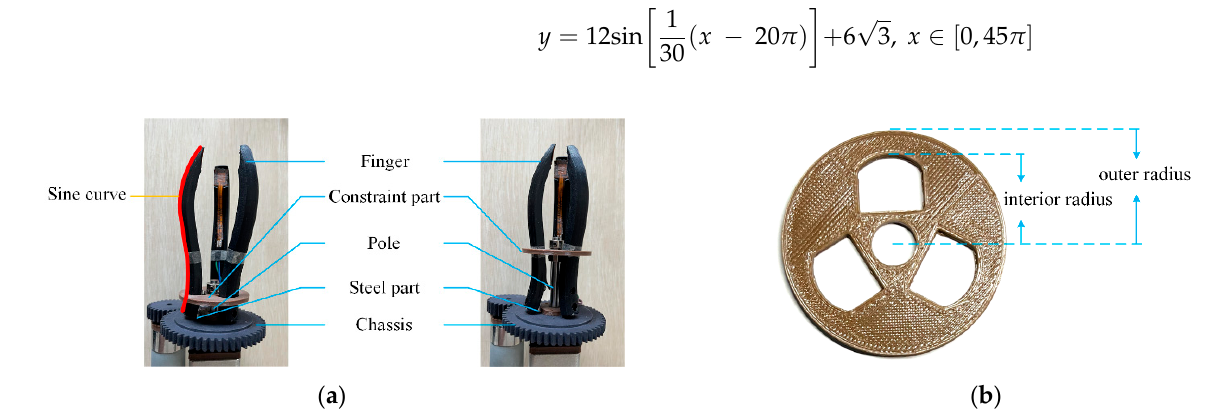
Figure 2. The design of gripper: ( a ) opening and closing of gripper; ( b ) the constraint part.